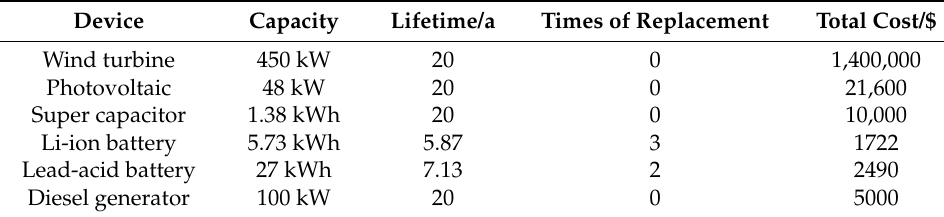
Table 8. Specified optimization result.